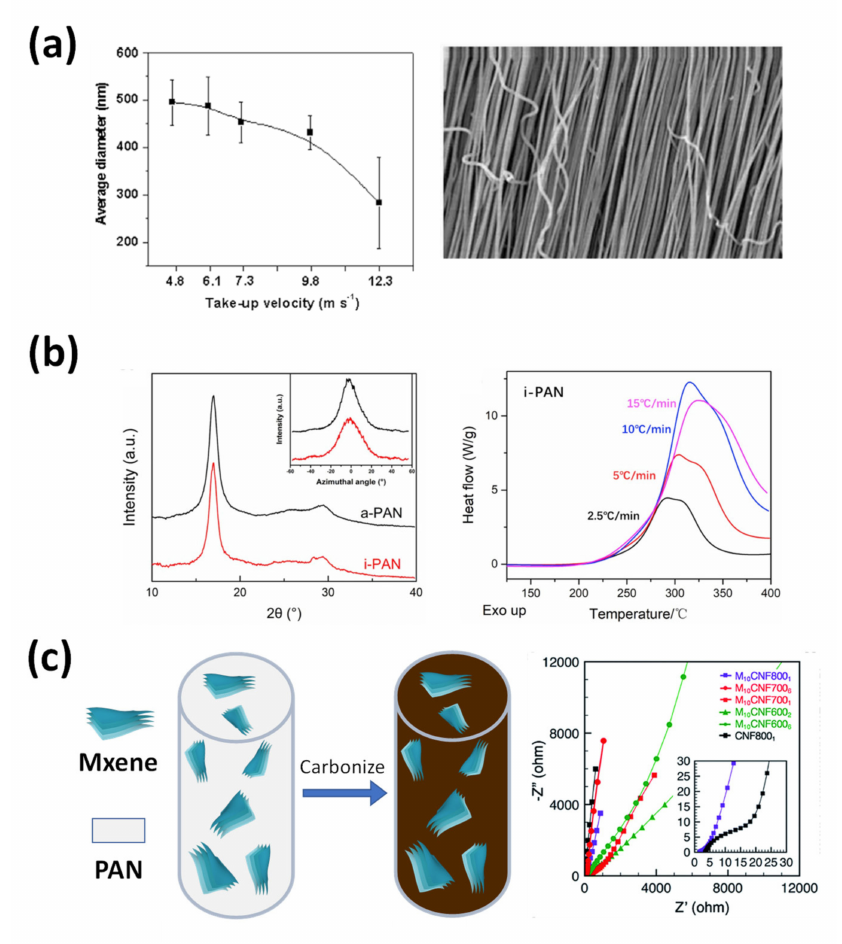
Figure 7. ( a ) The study of PAN as a precursor of electrospinning [65]. ( b ) Effect of isotacticity percentage of PAN on fibers after electrospinning and carbonization [66]. ( c ) Electrospinning fibers of PAN containing MXene and its carbonized material’s properties